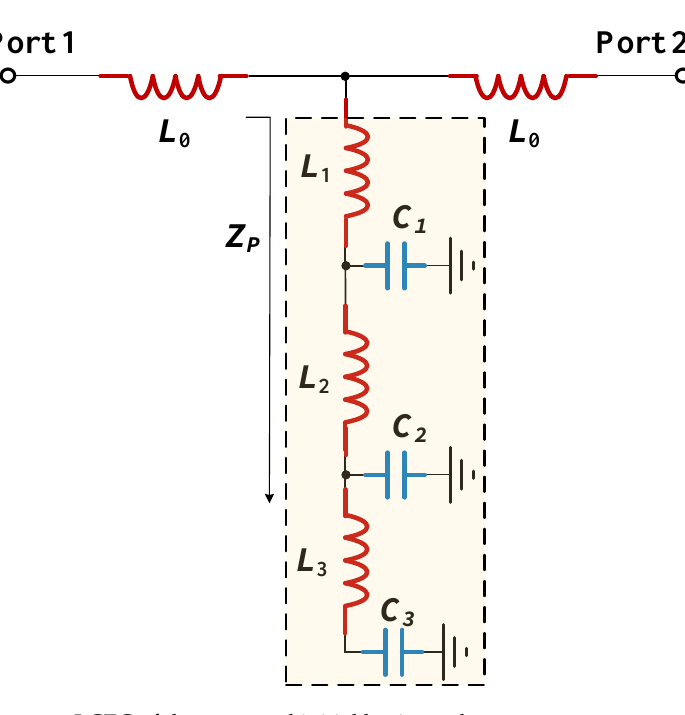
Figure 3. LCEC of the proposed initial horizontal resonator.